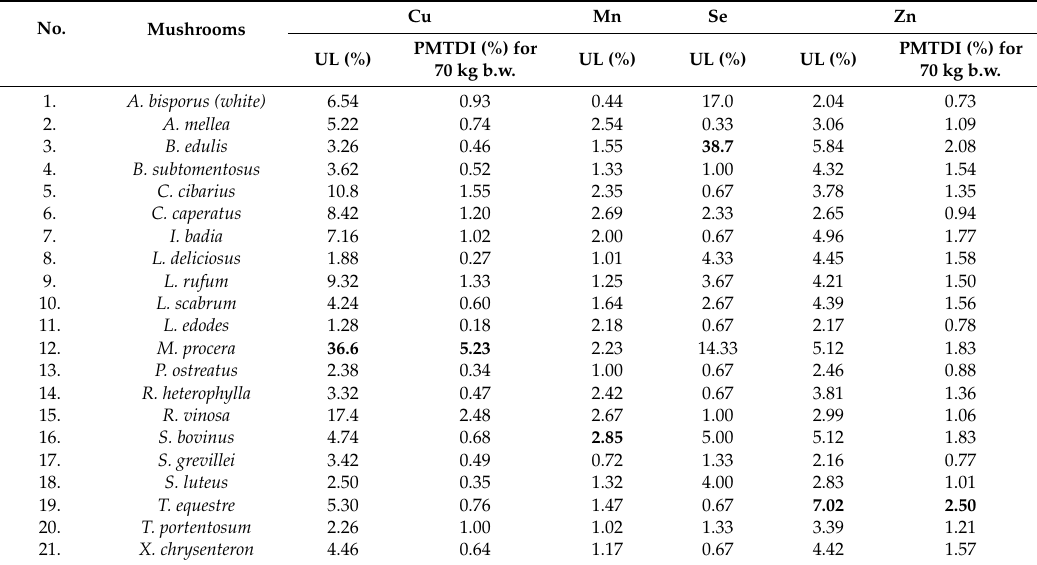
Table 7. Percentage of the elements contained in an edible portion (100 g FM) of the studied mushrooms in the implementation of the upper tolerable intake level (UL) and the provisional maximum tolerable daily intake (PMTDI) for Cu and Zn by a person with an average body weight of 70 kg.